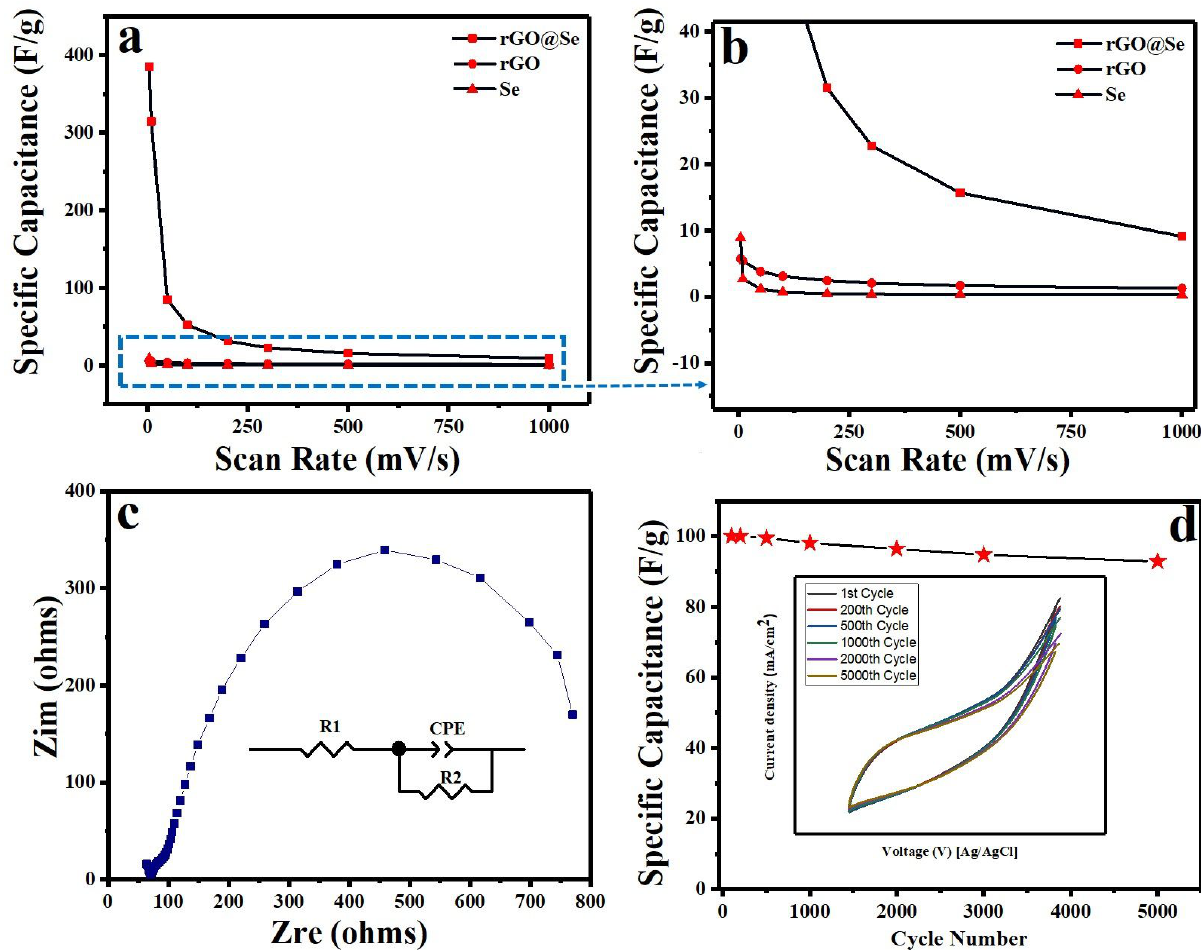
Figure 7: (a) Effect of scan rate on specific capacitance, (b) large scale for the marked area, (c) Nyquist plot (inset) corresponding equivalent circuit diagram, and (d) Specific capacitance retention as a function of cycle number (inset) corresponding cycle